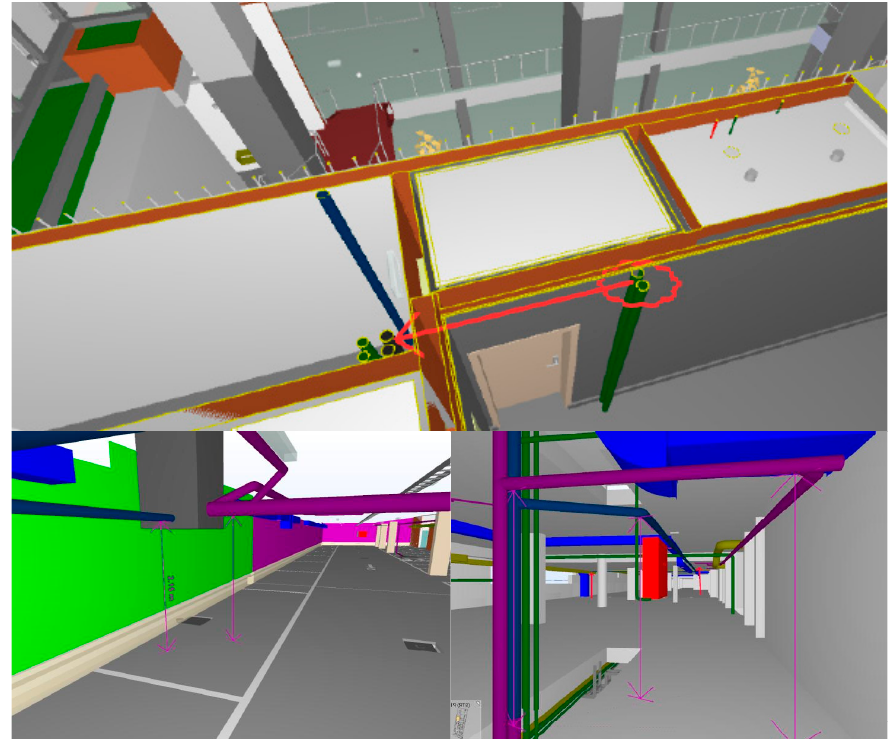
Figure 6. Virtual representation of collision between structural elements and facilities. Ventilation ducts and beam ( left ) and plumbing pipeline and pilar ( right ). BIM Model. 4.